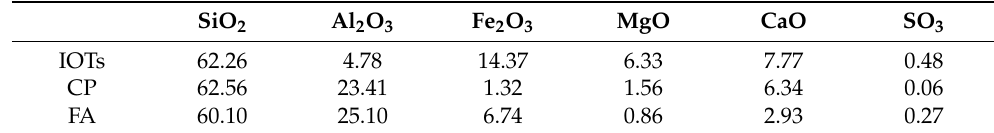
Table 1. Chemical composition and content of materials (mass fraction/%).